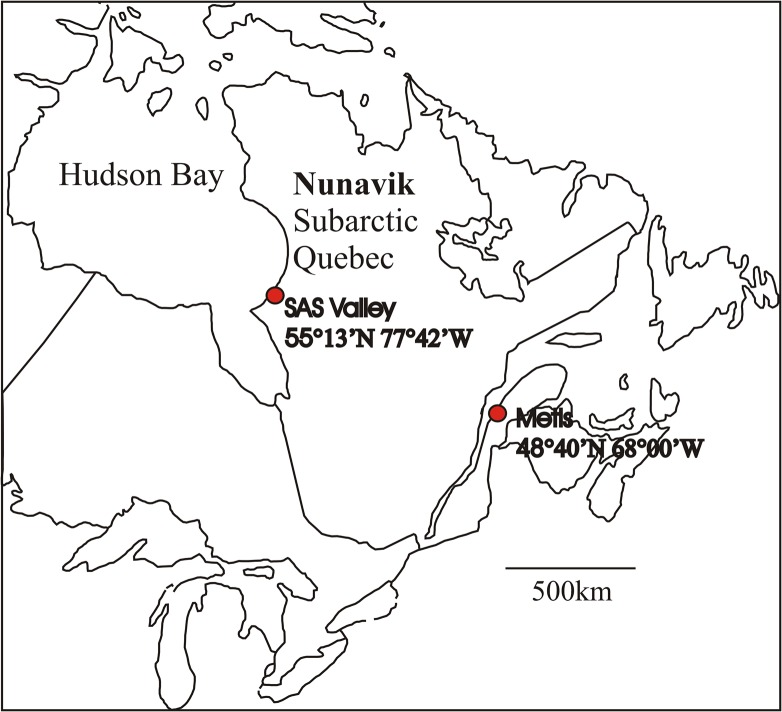
Location of the collection site for the zooplankton used in the growth experiments.The high latitude clone of D. pulex (Daphnia-HL) originated from a thermokarst pond in the SAS Valley (subarctic Québec) and the temperate clone from Metis (Jardins de Métis) in southern Québec (Daphnia-T).